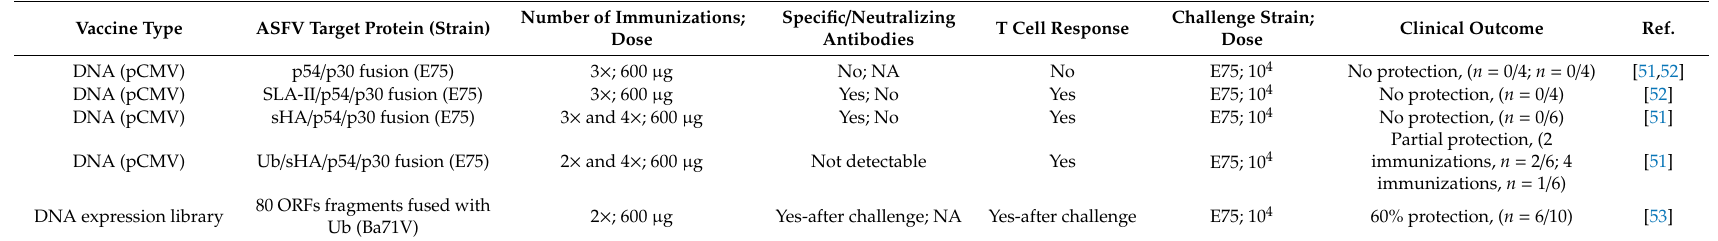
Table 2. DNA-based ASFV vaccines evaluated in the swine